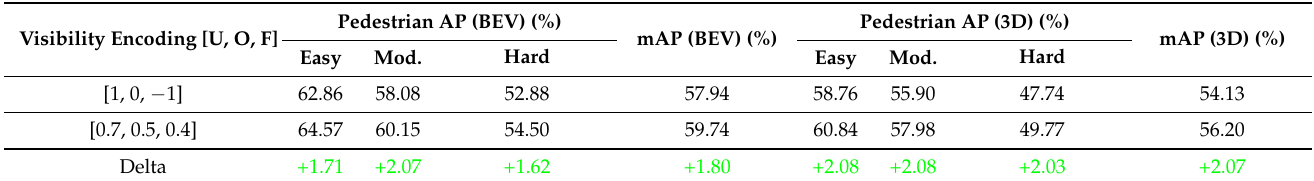
Table 3. Performance comparison of visibility state encoding for pedestrian detection on the KITTI validation dataset. Here, the baseline is tested with the integration of visibility